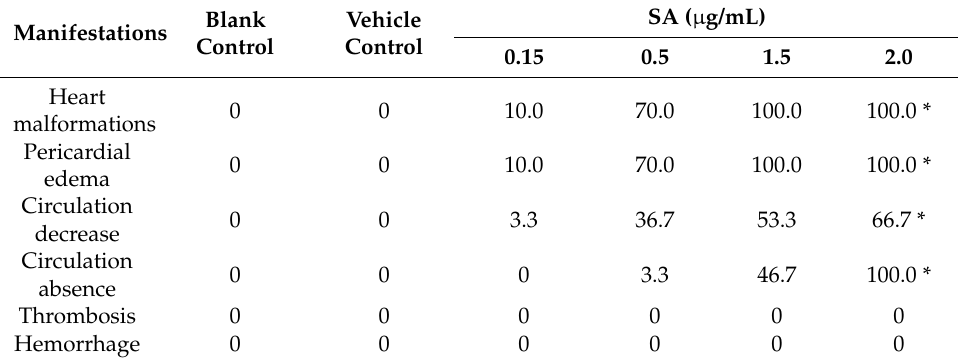
Table 1. Incidences (%) of visual cardiotoxic manifestations in zebrafish larvae.